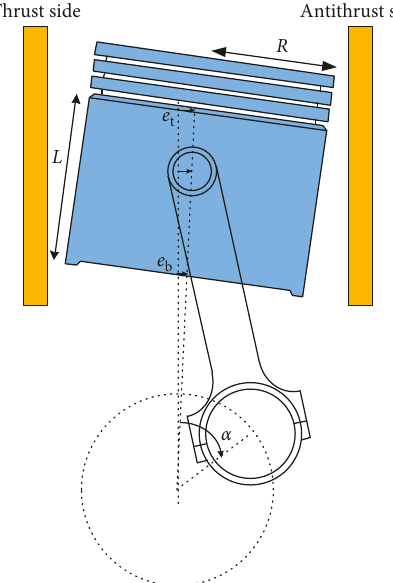
Figure 20: The dynamic model of the piston.